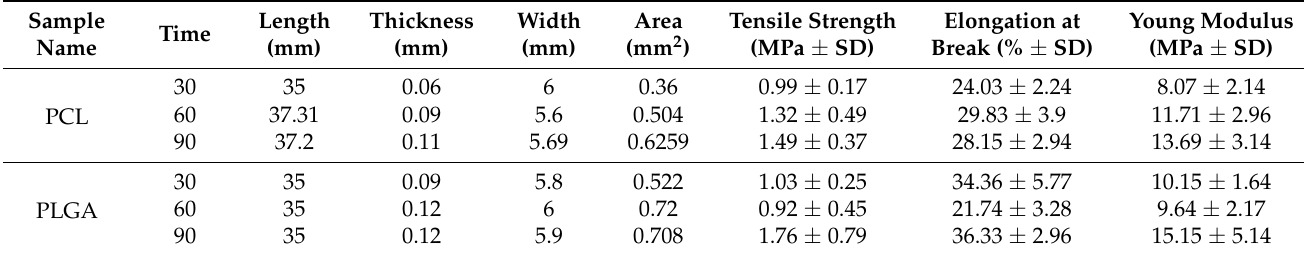
Figure 7. Tensile tests of electrospun PCL and PLGA scaffolds: photographs of flat sheet scaffolds during tensile testing of ( A ) 60-min PCL and ( B ) 60-min PLGA. ( C ) Stress–strain curves of electrospun nanofibrous structures. Table 4. Summary of mechanical properties for PCL and PLGA solutions electrospun for 30, 60 and 90 min.